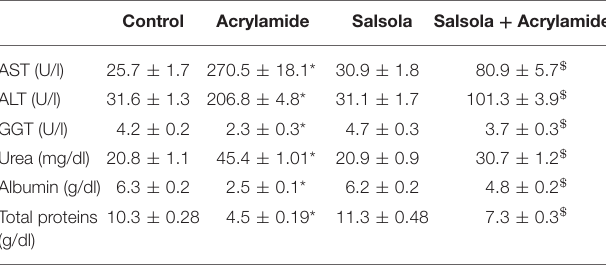
TABLE 3 | Protective impacts of Salsola extract on acrylamide-induced liver dysfunction in rats.